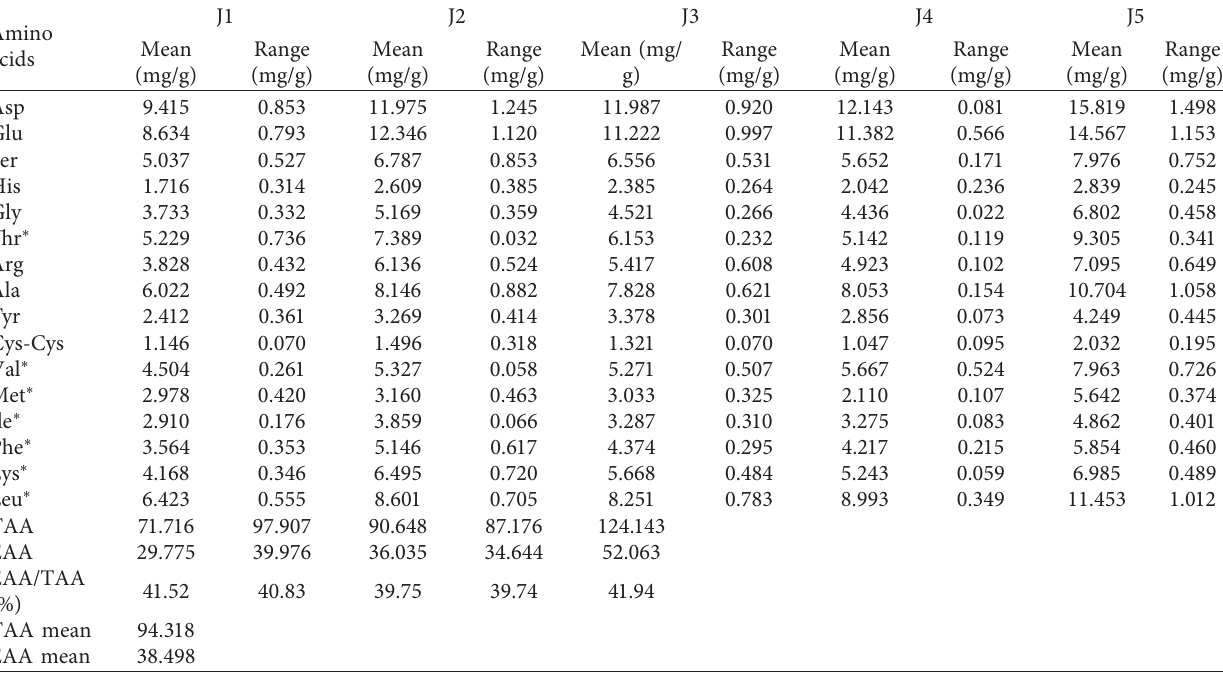
Table 3: Determination of amino acids in A. auricula from